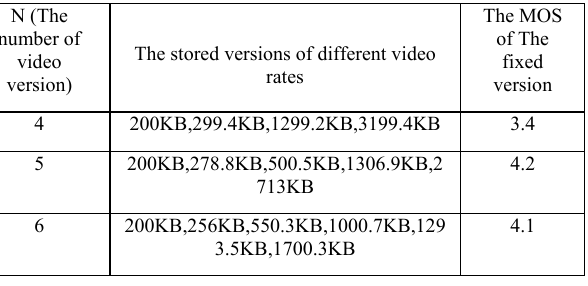
TABLE III ． The Specified Distribution of the Cache